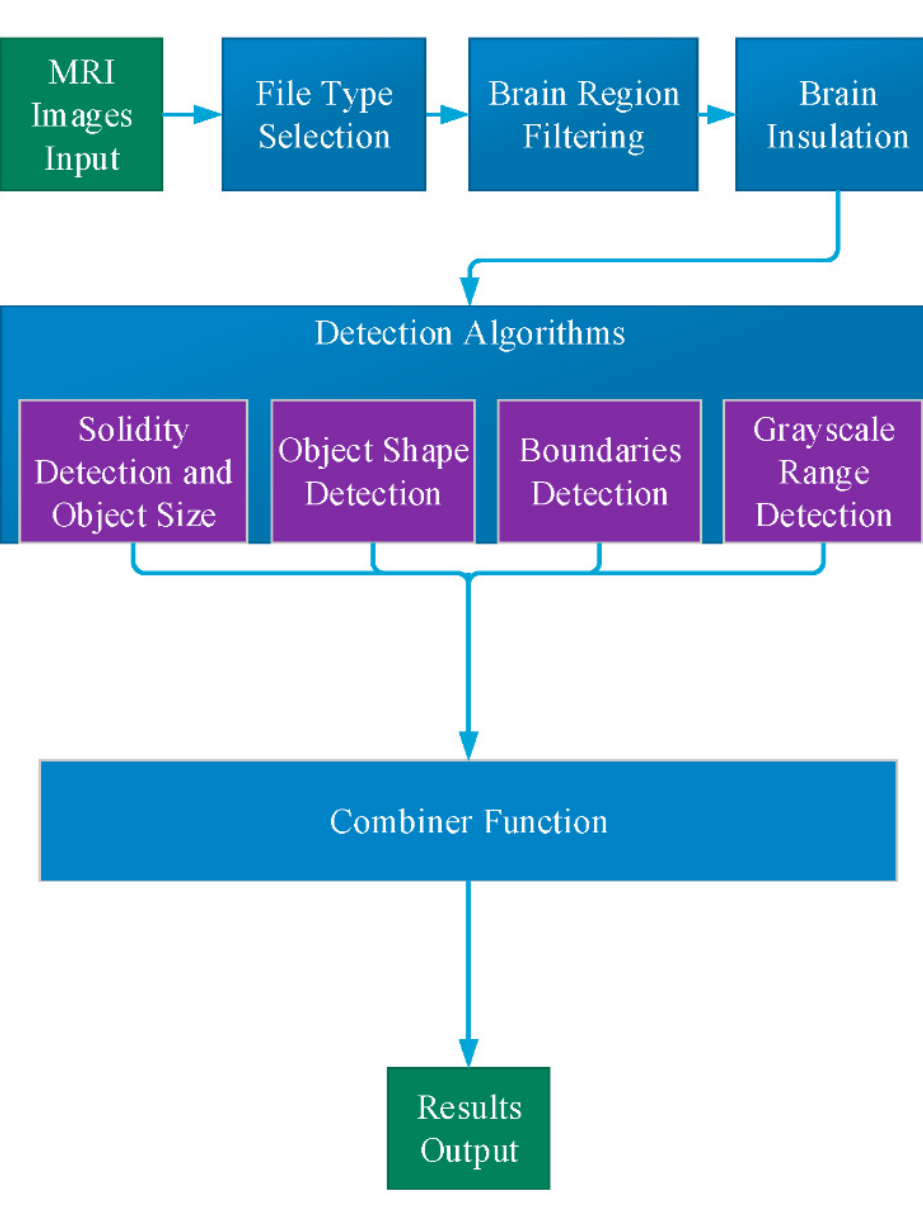
Figure 1. The full scheme of the algorithm.